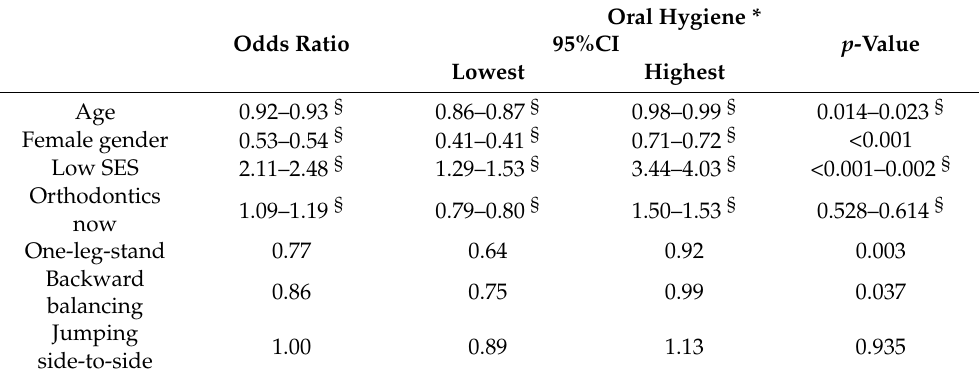
Table 5. Proportional odds model of oral hygiene (plaque level) and SES, sex, age, orthodontic treatment and coordination skills in children and adolescents of 10 to 18 years (Leipzig, Germany).